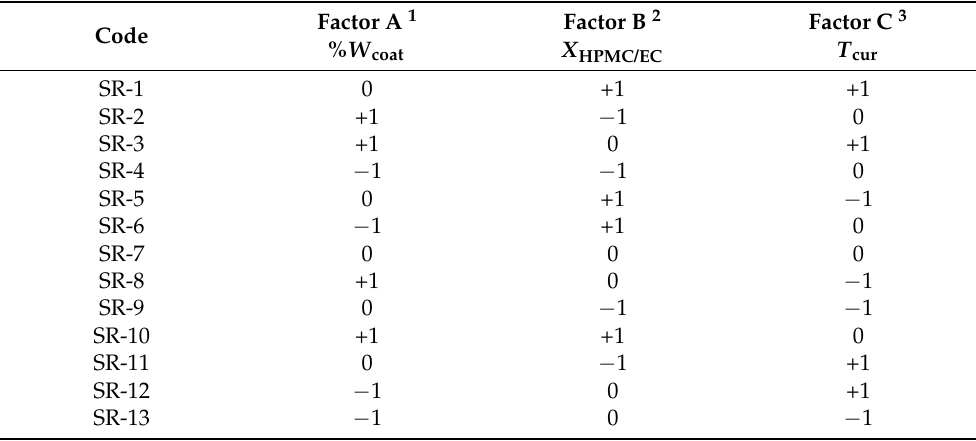
Table 1. The 3 3 DoE matrix of sobrerol SR pellets for a total of 13